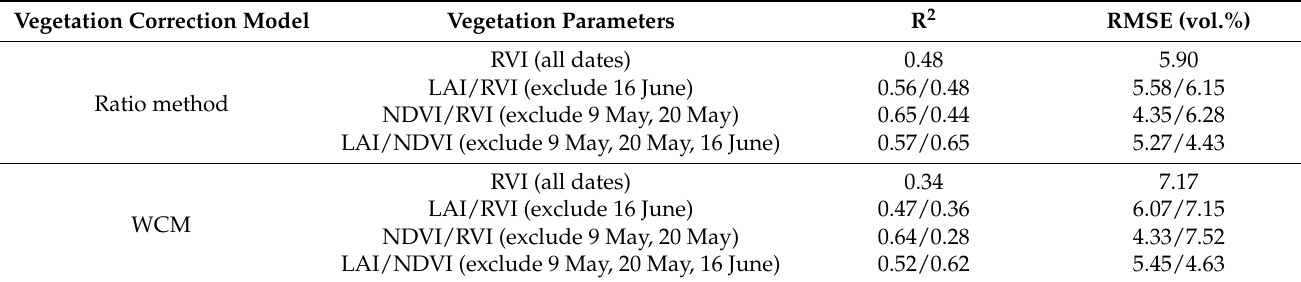
Figure 11. ( a ) Scatterplots between the measured and predicted SMC values on the validation set based on NDVI (WCM); ( b ) scatterplots between the measured and predicted SMC values on the validation set based on RVI, the same date as NDVI (WCM). Table 5. Estimation accuracy of validation set (comparison between LAI, NDVI, and RVI). Vegetation Correction Model Vegetation Parameters R 2 RMSE